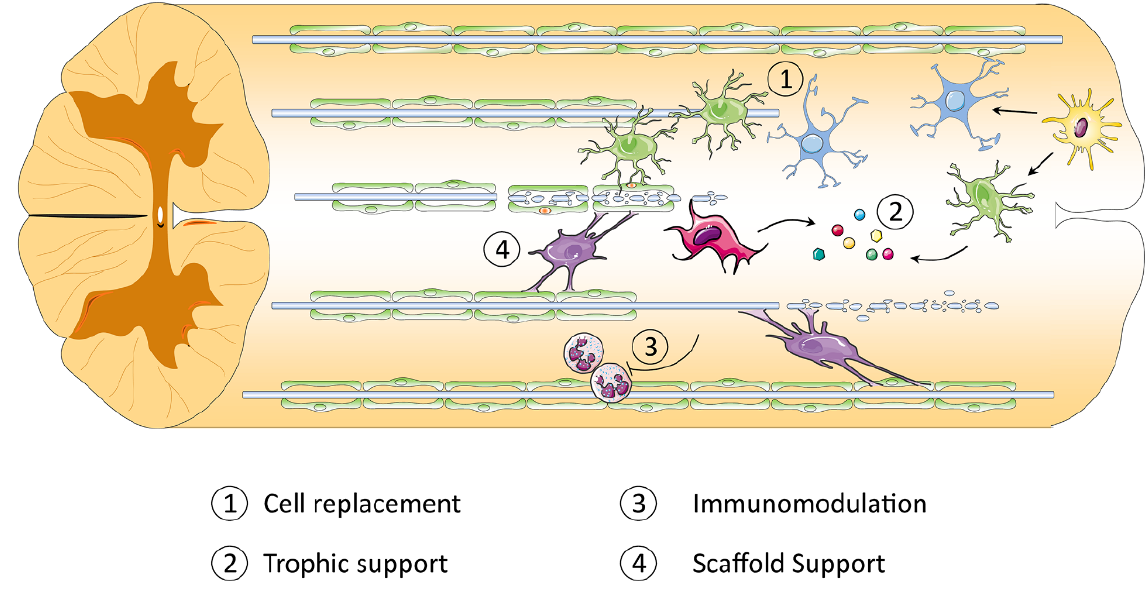
Figure 3. iPSC-derived cells exert their therapeutic effects for the treatment of SCI through different mechanisms. Some transplanted cells, like iPSC-derived neural progenitor cells (NPCs), can replace lost or damaged cells through differentiation or transdifferentiation into mature neurons and oligodendrocytes ① . iPSC-derived neurons and oligodendrocytes can also potentially replace lost or damaged cells. iPSC-derived cells, such as mesenchymal stromal cells (MSCs), NPCs astrocytes and oligodendrocytes, provide neurotrophic factors (like GDNF, NGF, BDNF and CNTF), which are crucial to